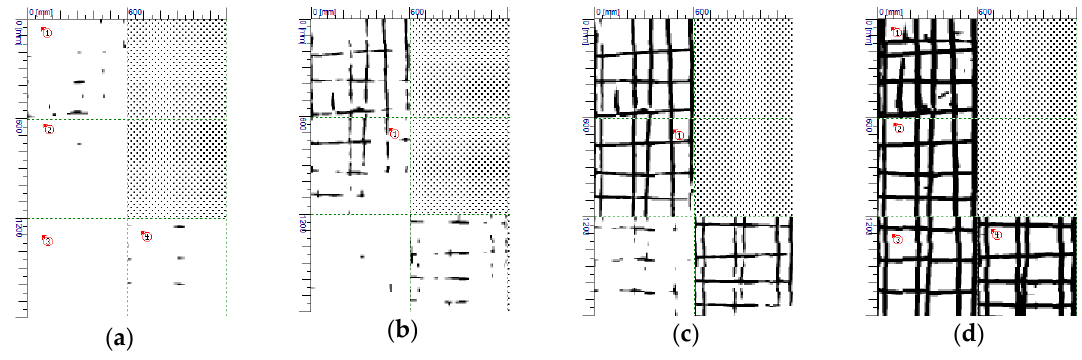
Figure 4. Image of reinforcement at depths: ( a ) 1–11 mm, ( b ) 5–15 mm, ( c ) 10–20 mm, and ( d ) 20–30 mm.